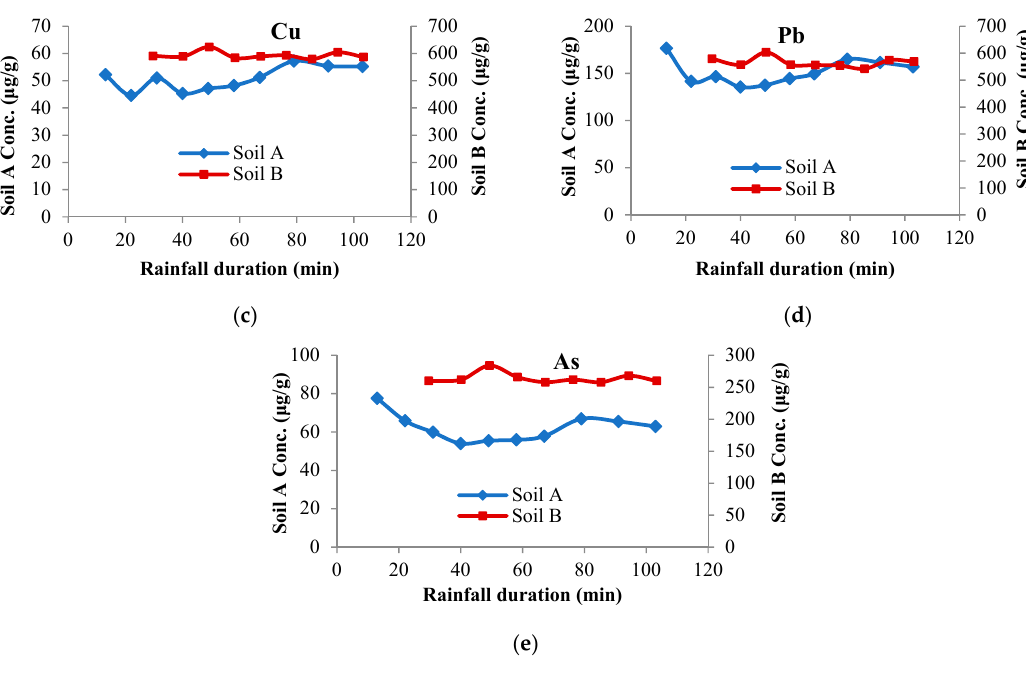
Figure 6. Concentrations of particulate: ( a ) Zn; ( b ) Cd; ( c ) Cu; ( d ) Pb; and ( e ) As in runoff from soils A and soil B during the simulated-rainfall experiment. Note: different scales on secondary y-axes.